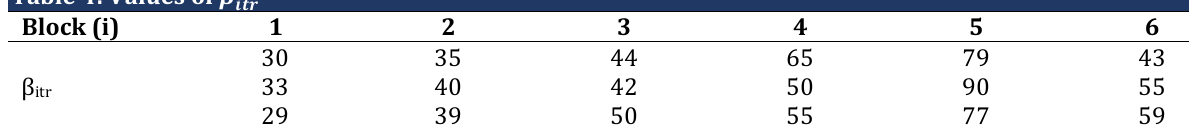
Table 4: Values of 𝜷